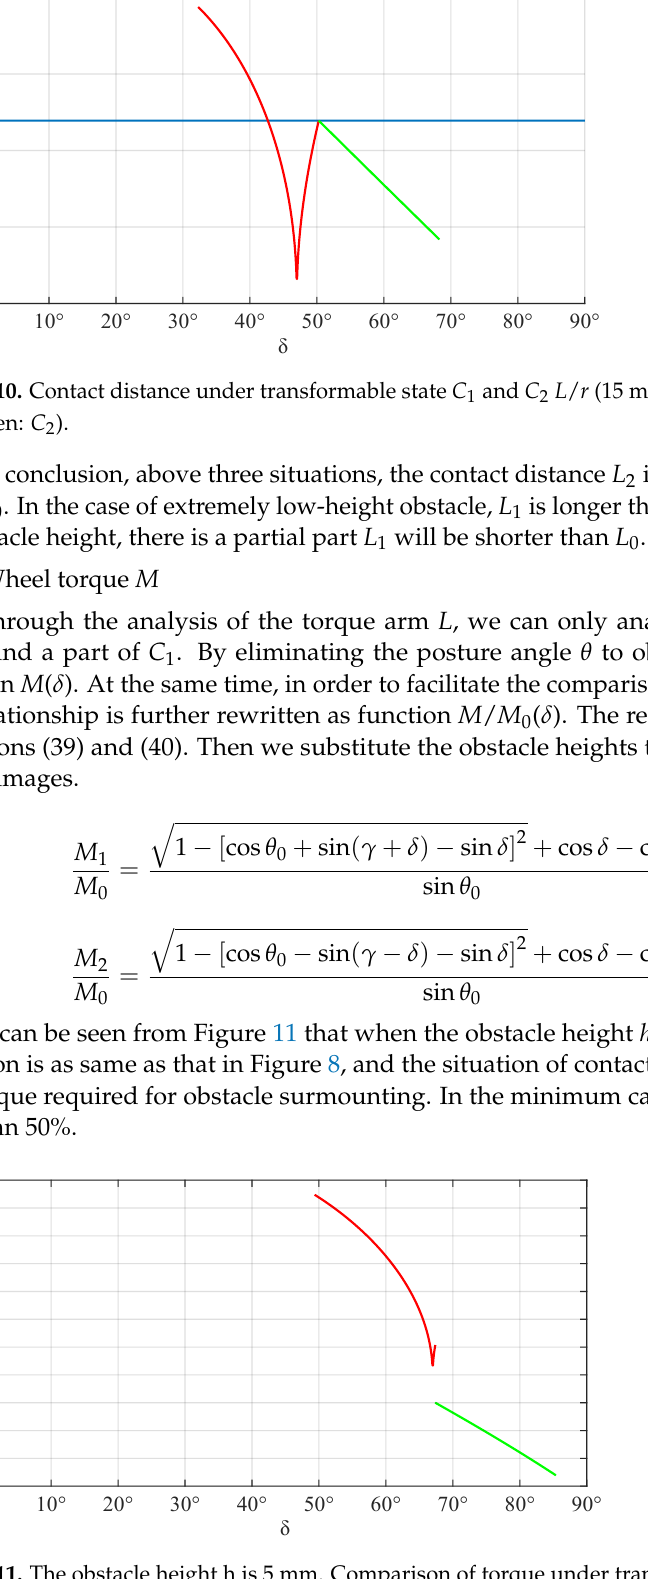
Figure 9. Contact distance under transformable state C 1 and C 2 L / r (10 mm) (Blue: wheel state; Red: C 1 ; Green: C 2 ).